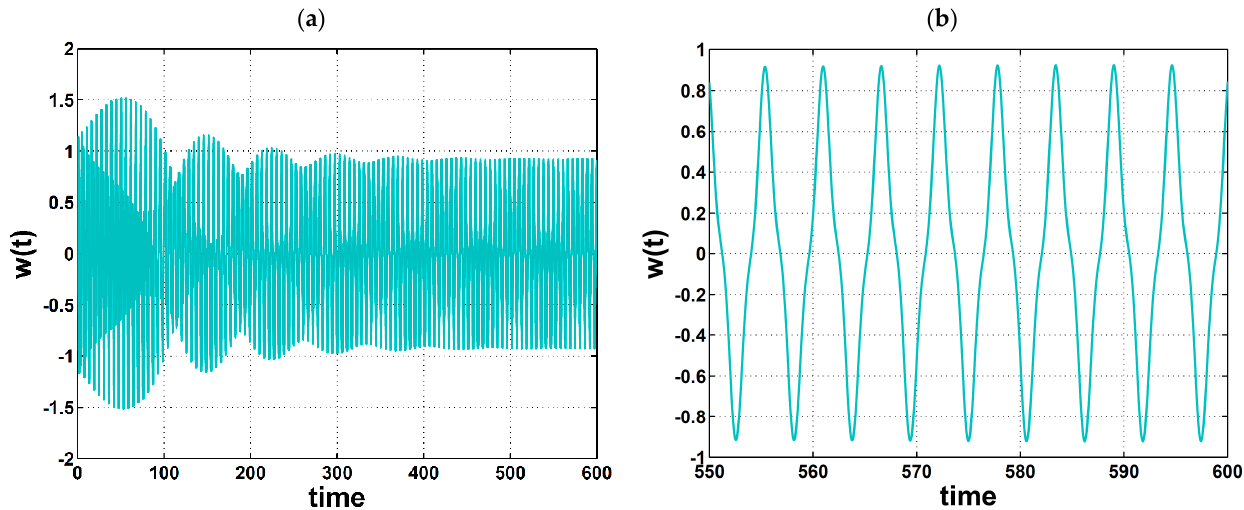
Figure 13. The time history of the car pre-control ( k p = k v = 0) at ω = 1.12, k = 7, β = 0.8, and ζ = 0.02: ( a ) total trace for 600 s and ( b ) last 50 s of the total